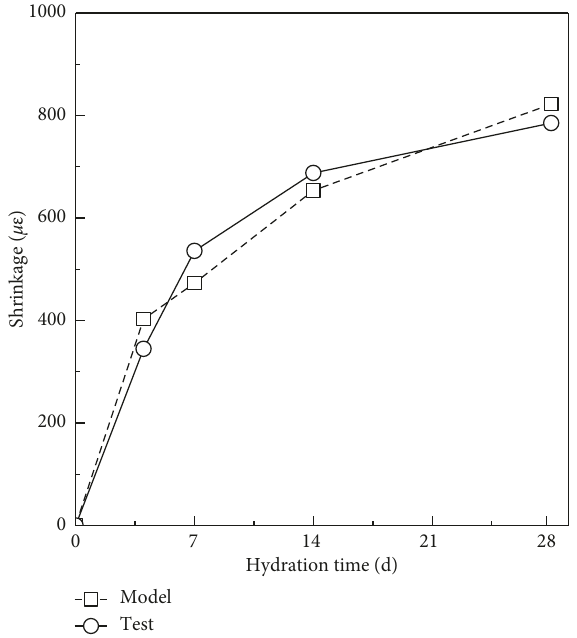
Figure 5: Comparison between calculated and measured values of shrinkage model.